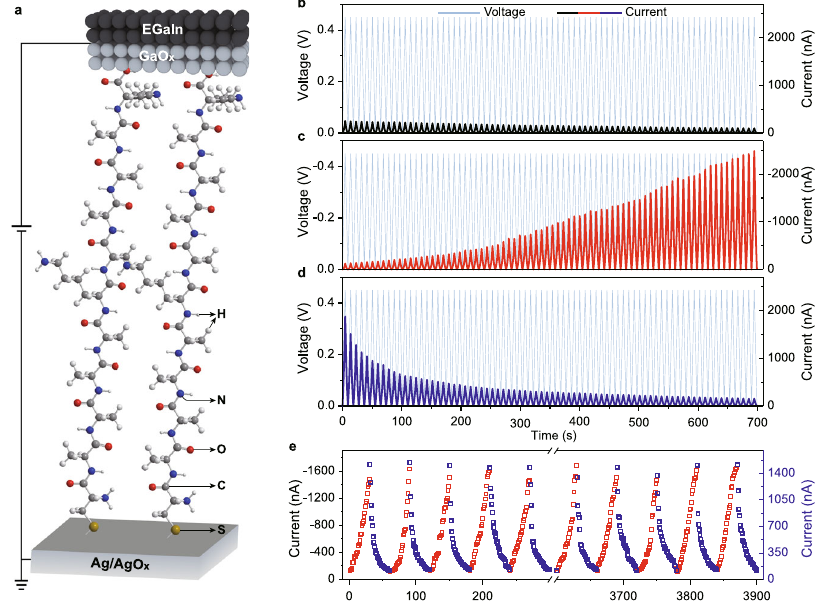
Fig. 1 | Molecular synapse architecture and dynamic current – voltage char- acteristics. a Scheme of the molecular synapse device containing a bottom Ag/AgO x electrode, peptide SAM, and a liquid GaO x /EGaIn top electrode, Ag/AgO x //CAAAAKAAAAK//GaO x /EGaIn. The Ag/AgO x electrode is prepared by thermal annealing electron-beam evaporated Ag layer (200nm) at 150°C for 40min in air. Current signals ( black , red , and blue curves) recorded by